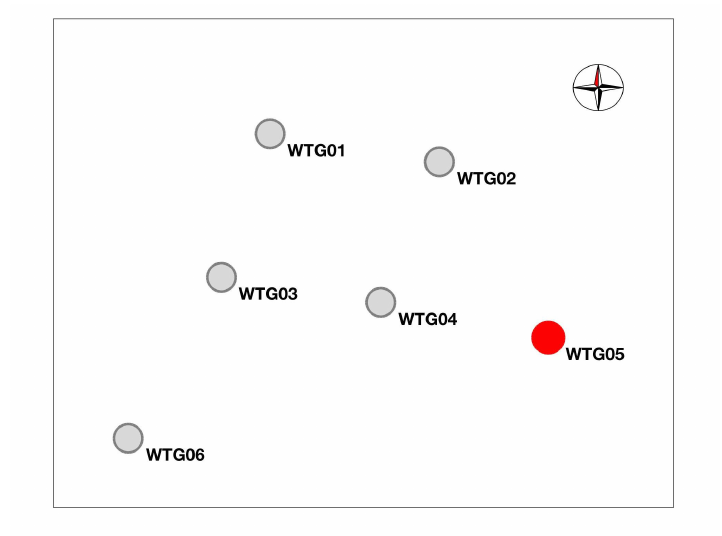
Figure 1. The layout of the wind